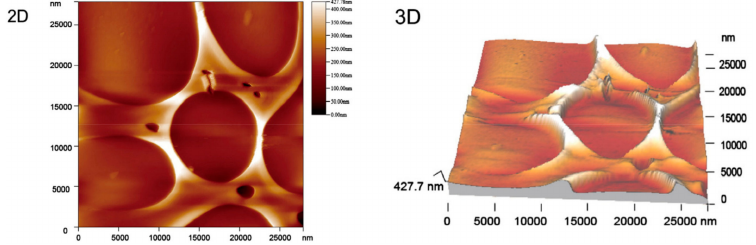
Figure 9. AFM images of the oxide system (90)TiO 2 -(10)ZnO (created based on [157] with permission from Elsevier